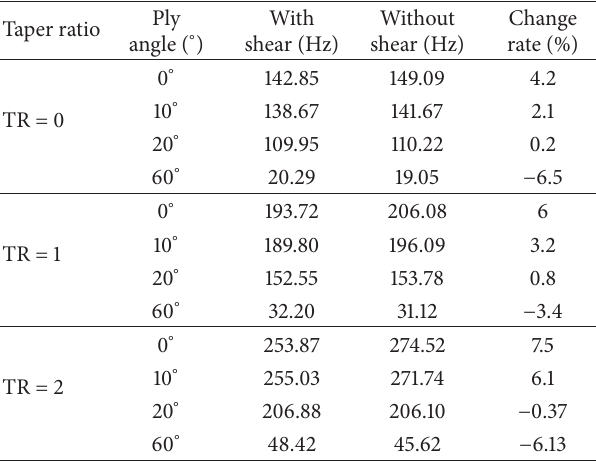
Table 3: Shear stress effects on the first natural frequency ( Ω = 100rad/s).